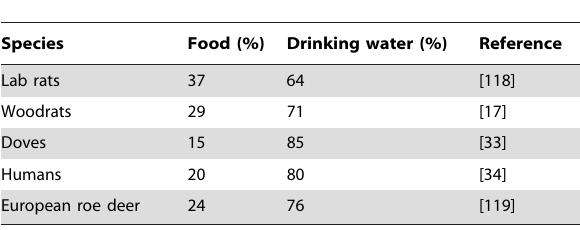
Table 1. Food and drinking water inputs of hydrogen in the body water of different organisms under laboratory